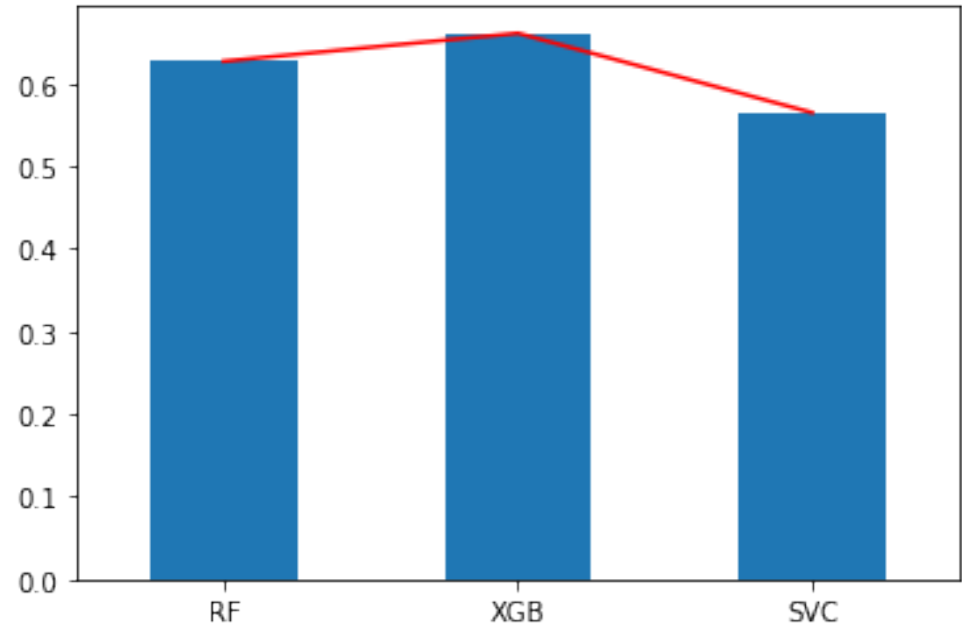
Figure 5. F 1 scores for GloVe embeddings, without any feature selection